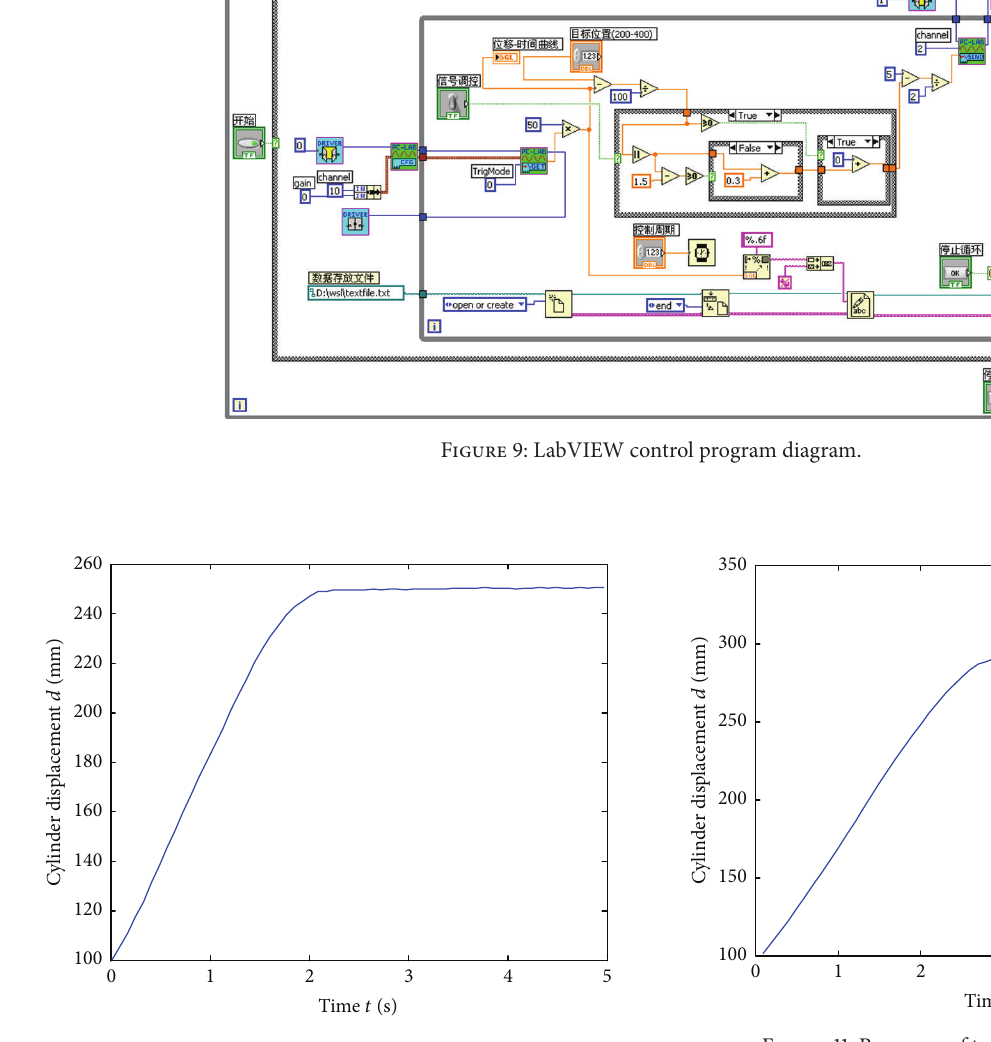
Figure 10: Response of target position 250 mm. Figure 11: Response of target position 300